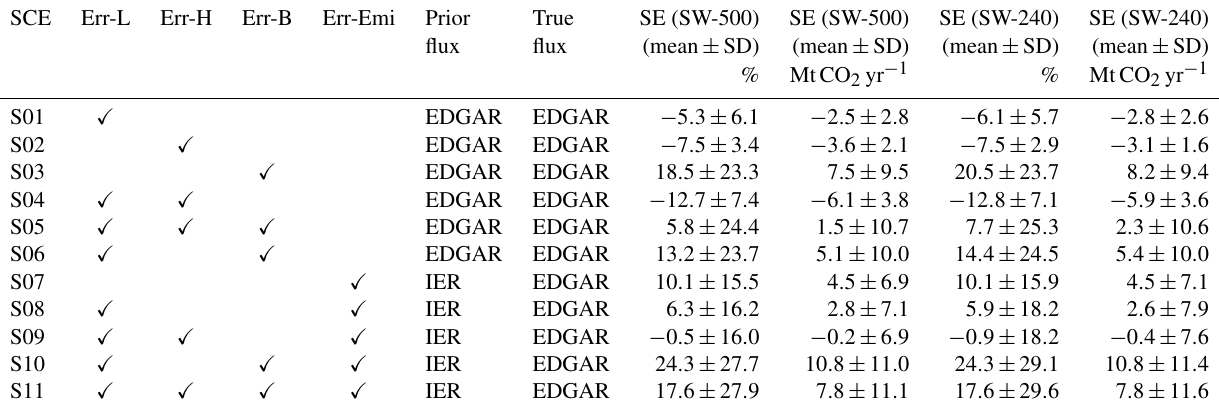
Table 1. Overview of different scenarios (SCE) which are used to investigate the systematic errors of the retrieved emissions. The absolute mean and standard deviations are estimated for two swath widths (SW-500: 500km and SW-240: 240km) for all N useful overpasses and are expressed in both MtCO 2 yr − 1 and in percent. Err-L, Err-H, and Err-B indicate errors attributed to CarbonSat measurement, high-resolution, aerosol-related errors, and biogenic modelling errors, respectively. Err-Emi indicates whether the inversion experiment uses different prior emission fluxes (see Sect. 4.3).